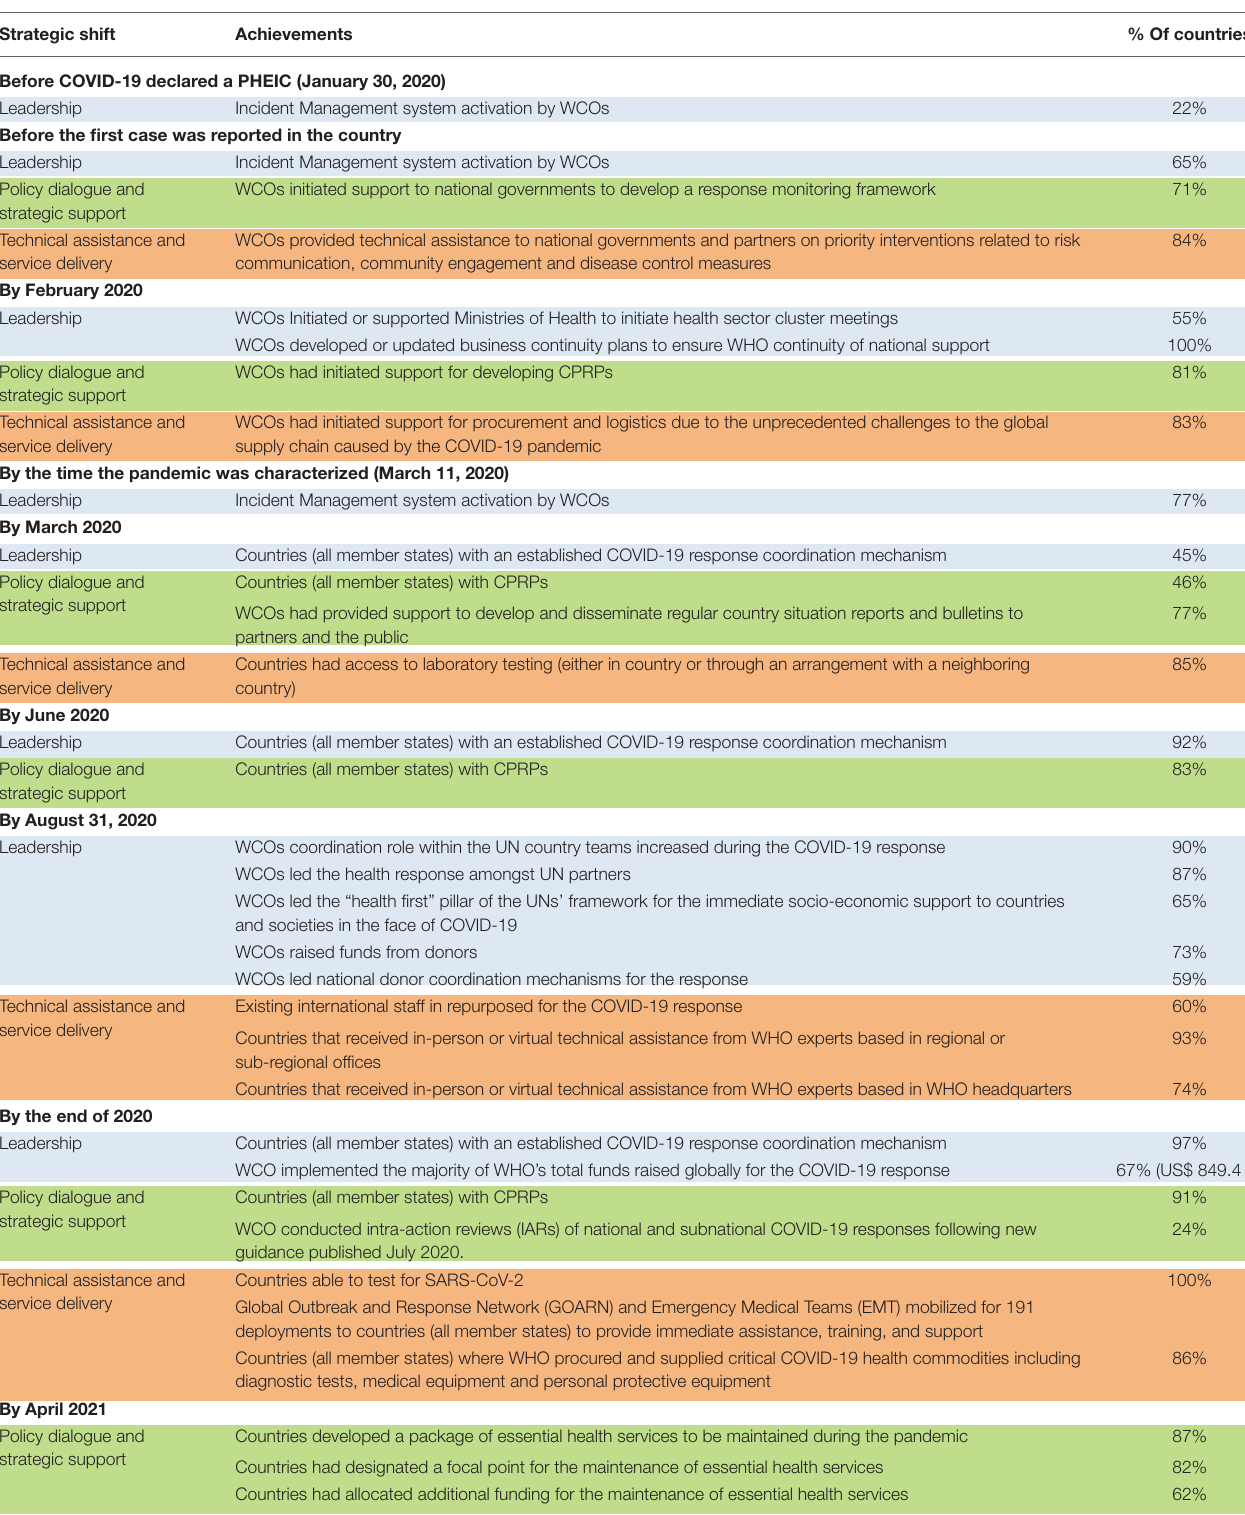
TABLE 1 | Timeline of key WHO frontline support during the first year of the COVID-19 pandemic. Strategic shift Achievements % Of